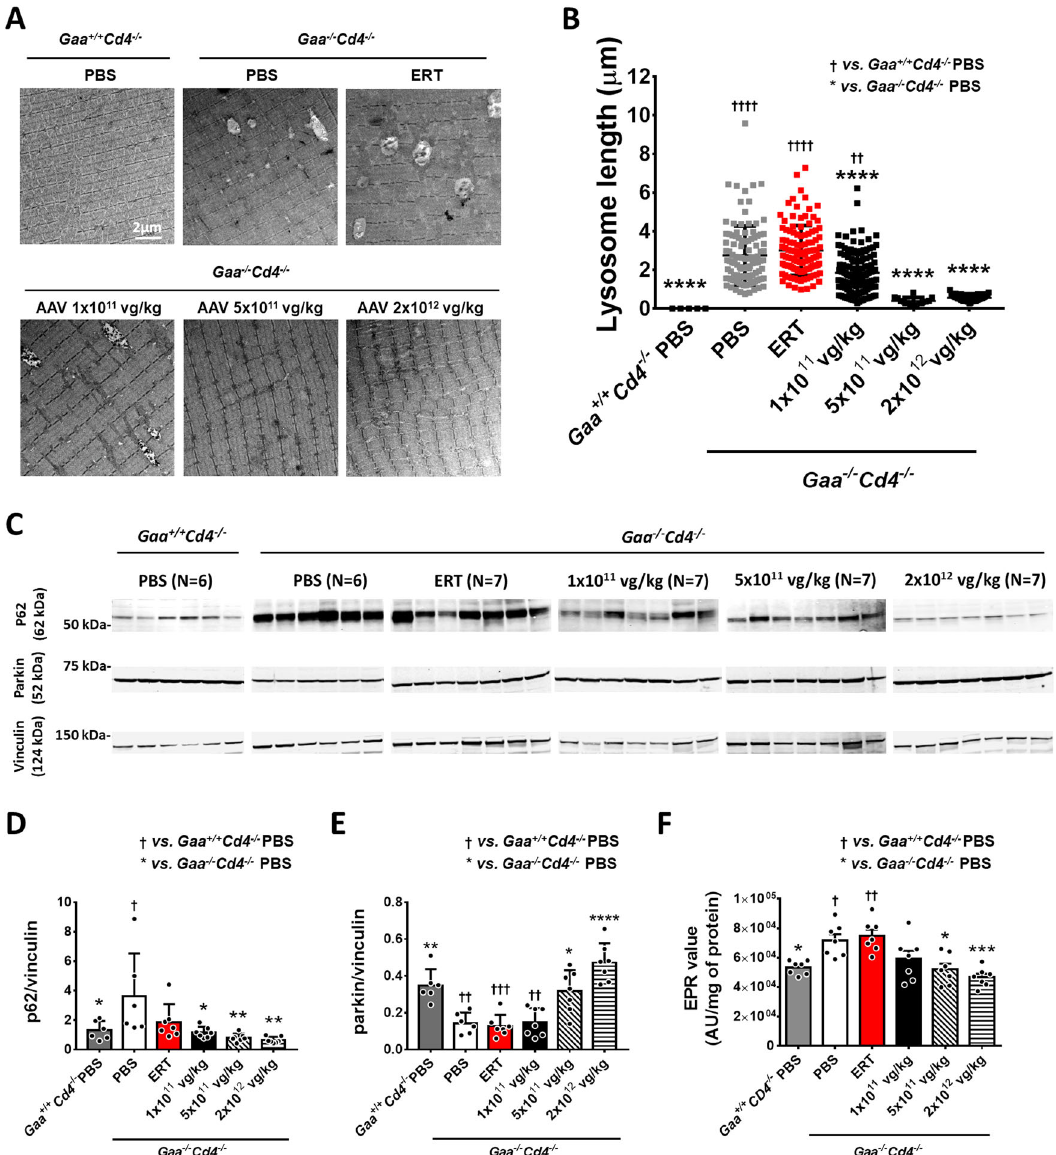
Fig. 5 AAV-GAA gene transfer provides better correction of lysosomal enlargement and mitochondrial function compared to enzyme replacement therapy (ERT). A Representative electron microscopy scans of tibialis anterior sections. B Quanti fi cation of lysosomal length from electron microscopy images ( n = 2 per treatment group; number of lysosomes counted and used for statistical analysis: Gaa + / + Cd4 − / − PBS, n = 4; Gaa − / − Cd4 − / − PBS, n = 108; ERT, n = 113; AAV-GAA 1 × 10 11 vg/kg, n = 136; AAV-GAA 5 × 10 11 vg/kg, n = 14; AAV-GAA 2 × 10 12 vg/kg, n = 37). C Western blot analysis